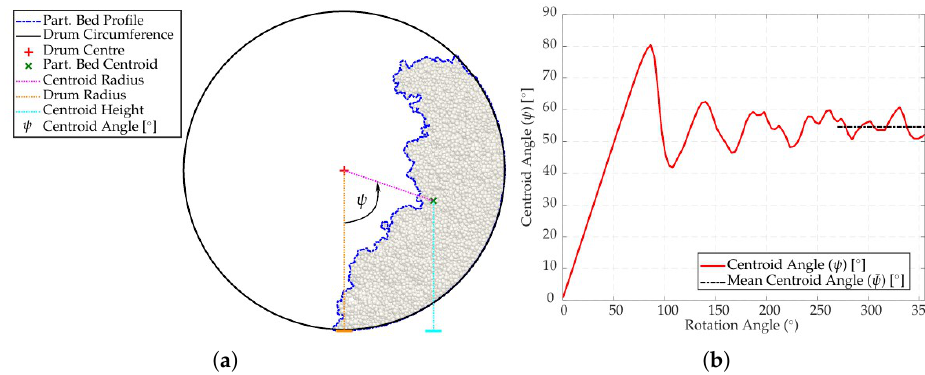
Figure 20. ( a ) The measurement of the material bed’s centroid (Particle bed analysis) and ( b ) the centroid angle ψ as a function of time (Mean centroid angle).